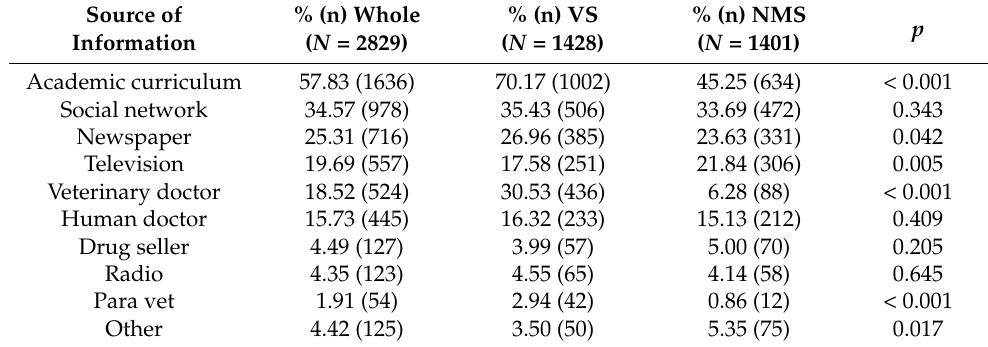
Table 4. Sources of information about antibiotics resistance.